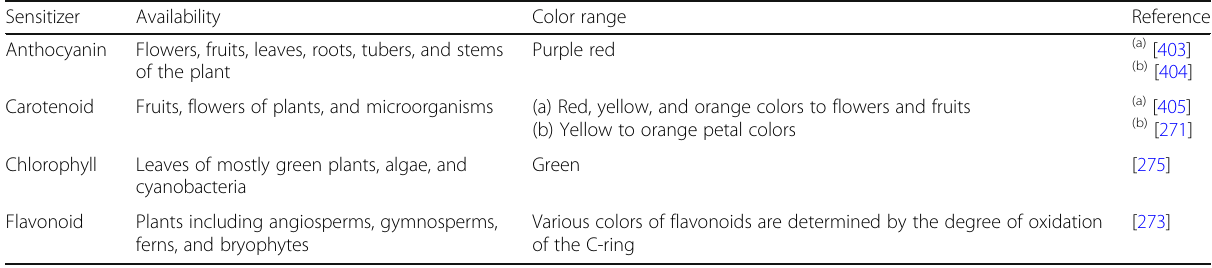
Table 5 Availability and color range for the natural dyes (anthocyanin, carotenoid, chlorophyll, and flavonoid) Sensitizer